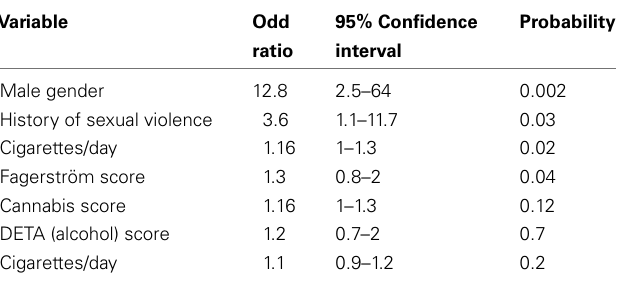
Table 3 | Correlations between agitation (OAS score) and all quantitative parameters.